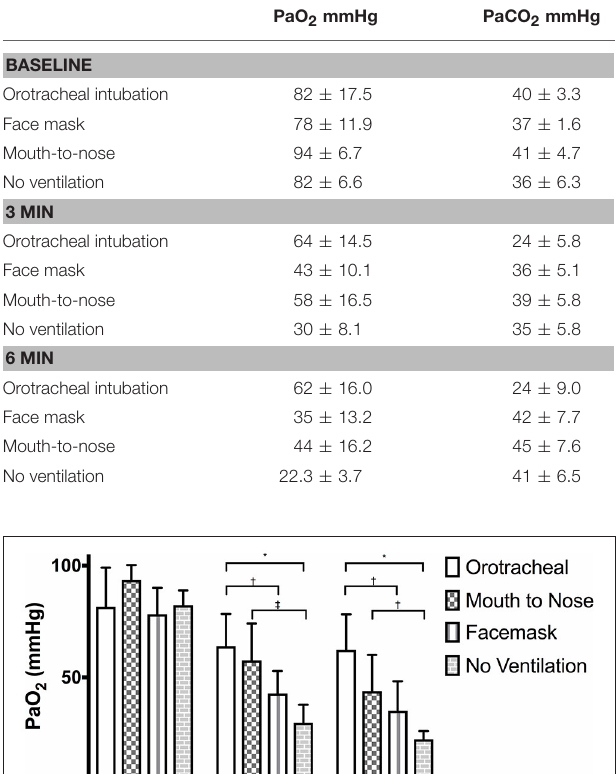
TABLE 1 | Mean and standard deviation values of PaO 2 and PaCO 2 values of dogs during closed chest cardiopulmonary resuscitation receiving one of four methods of ventilation ( N = 6 for all groups).